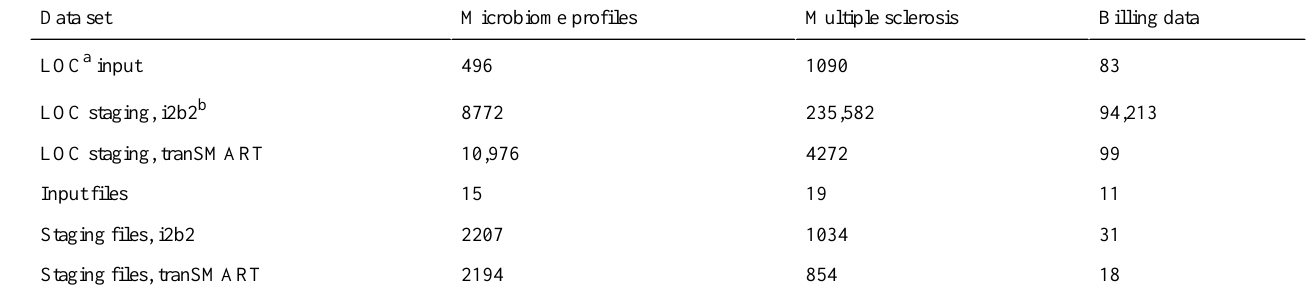
Table 2. Comparison of input required for data loading.